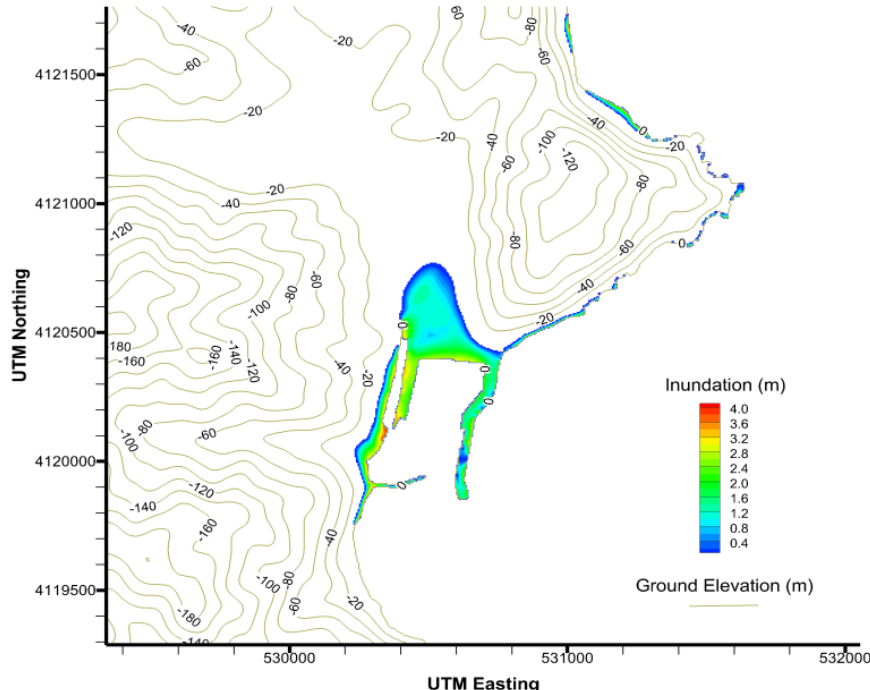
Figure 7. Maximum inundation map.